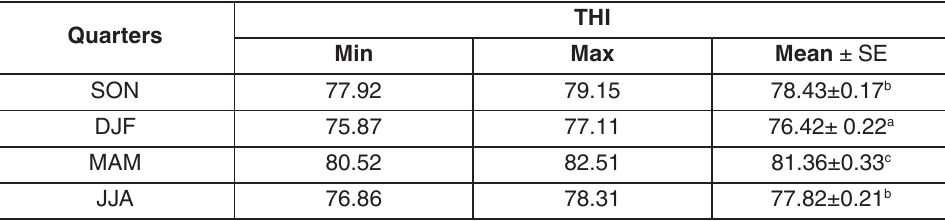
table 2. Maximum, minimum and daily mean THI values across quarters Quarters